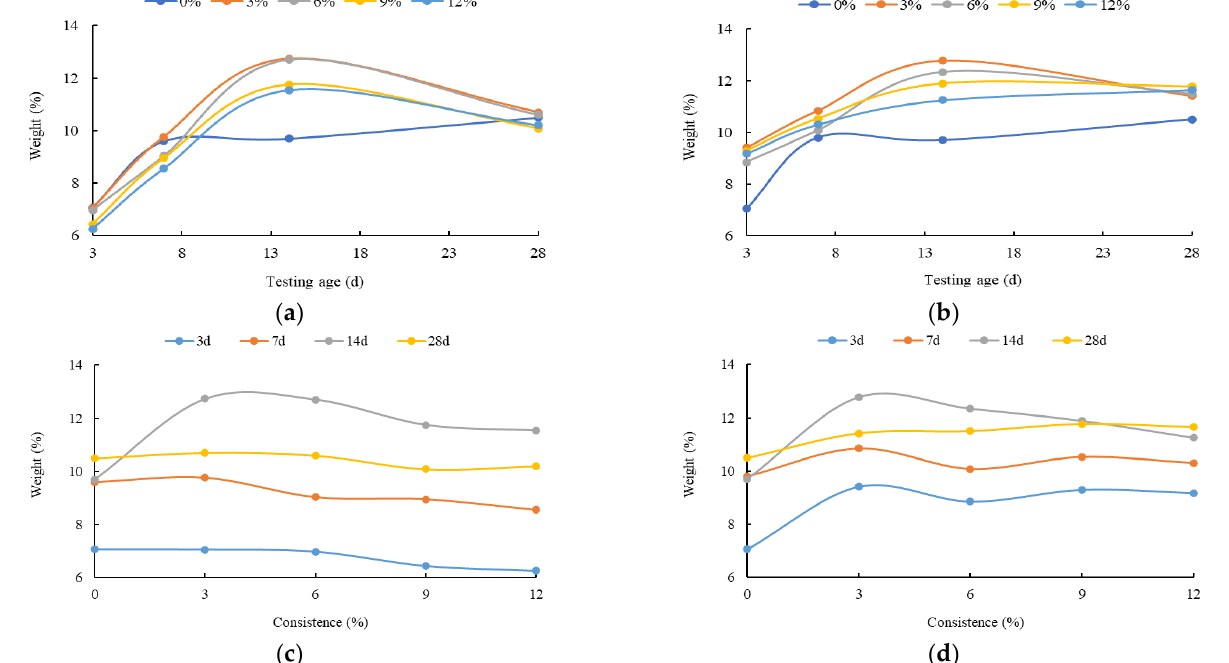
Figure 8. Mass loss rule of hydration products in the first stage of endothermic peak: ( a ) IN; ( b ) OU; ( c ) IN; ( d ) OU